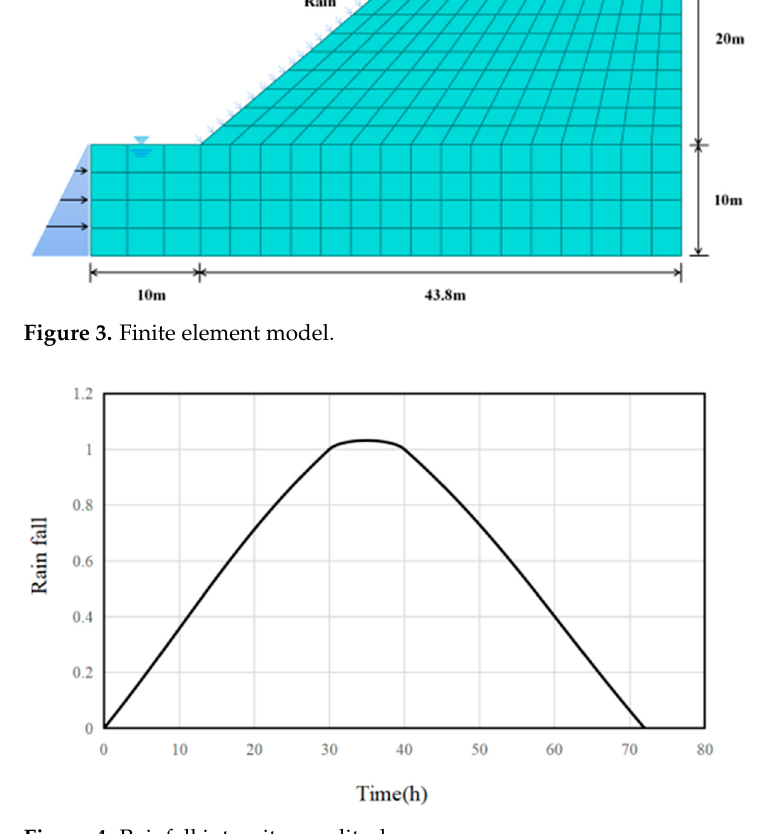
Figure 4. Rainfall intensity amplitude.